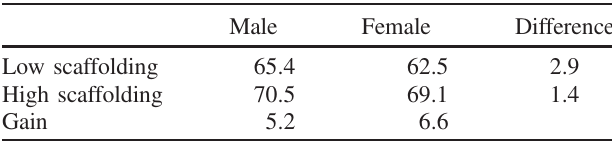
TABLE IV. Average performance by gender on exam questions assigned to the low and high scaffolding groups. Difference represents the average difference in exam grade between genders. Gain represents the increase in average exam score as a result of increased scaffolding.